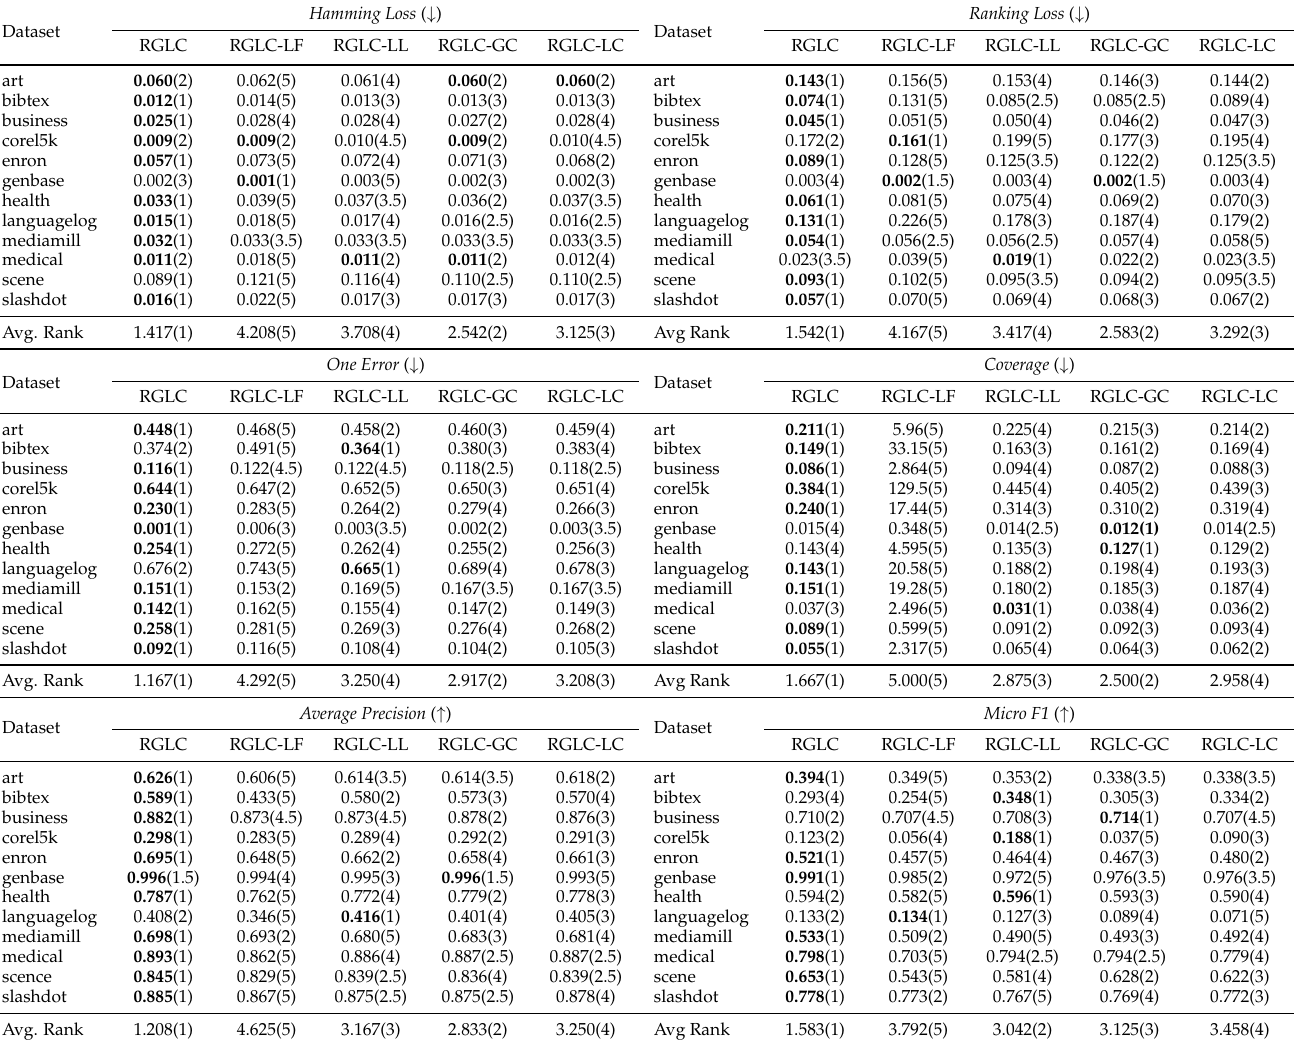
Table 5. Comparison of each component in RGLC. Best results are in bold size. ↓ : the smaller the better; ↑ : the larger the